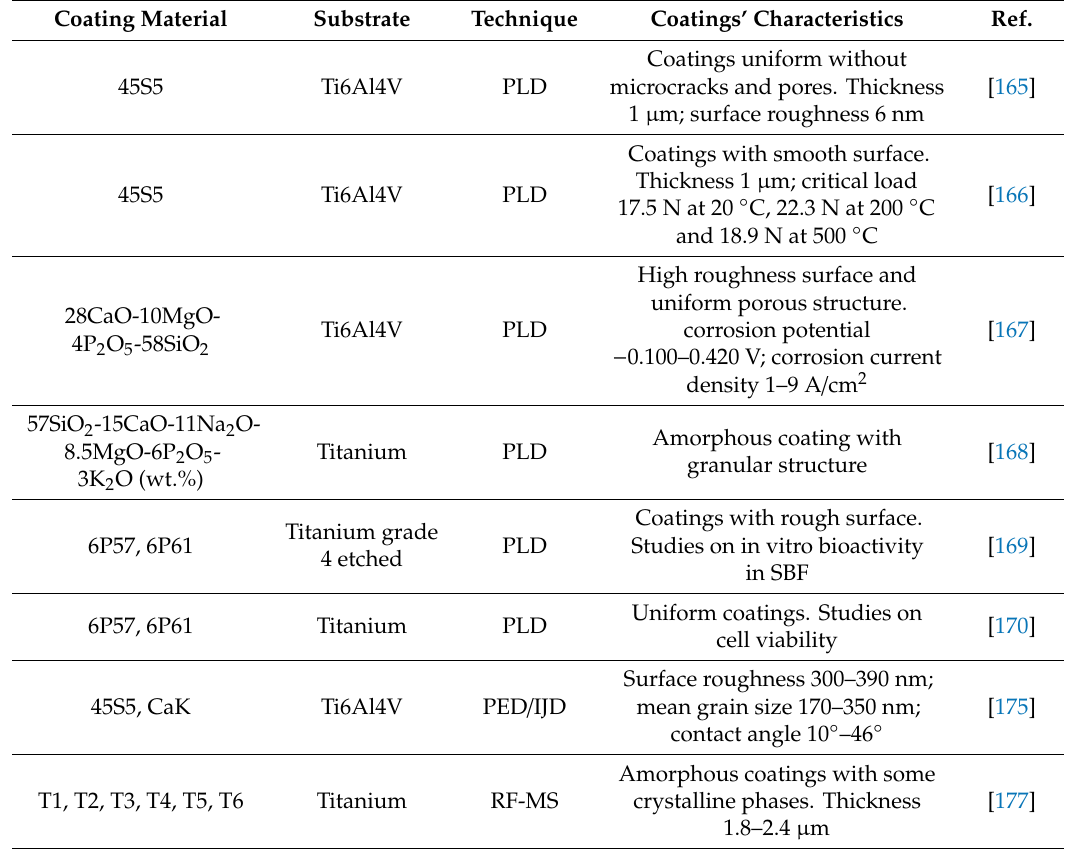
Table 5 summarizes thin bioactive glass coatings obtained by di ff erent techniques. Table 5. Summary of thin bioactive glass